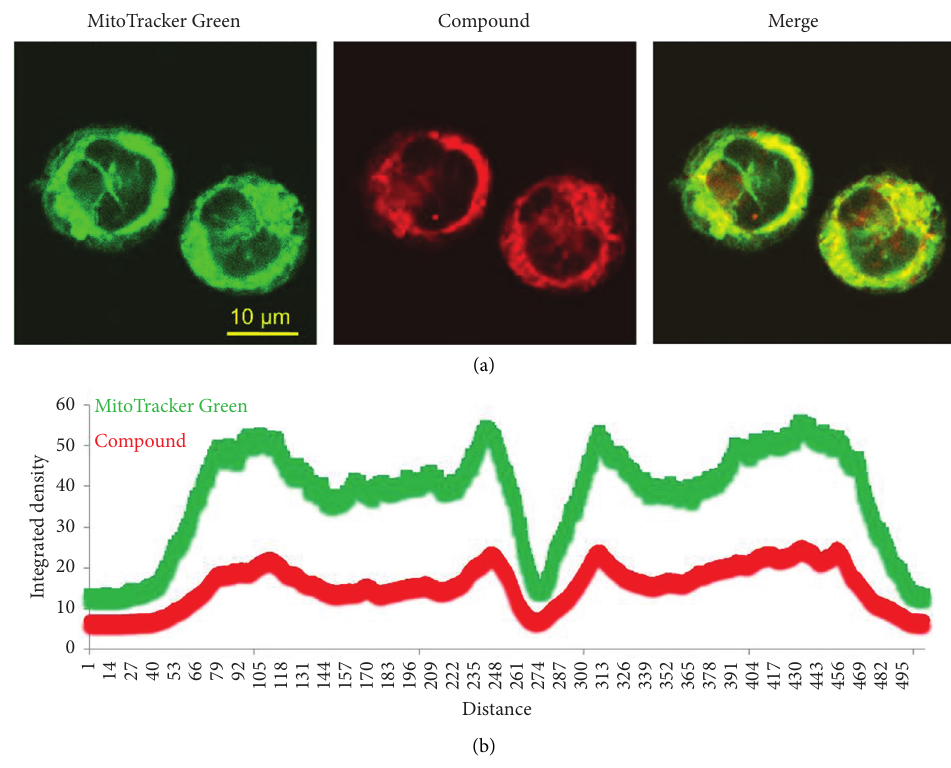
Figure 3: Mitochondria staining in the cancer cells. (a) Confocal images of K562 cells stained using 5 μ M compound (red) for 40min and 400nM MitoTracker Green dye for 15min. (b) Quantification of the red and green signals for one virtual line set along the X -axis direction in the middle of the Y -axis